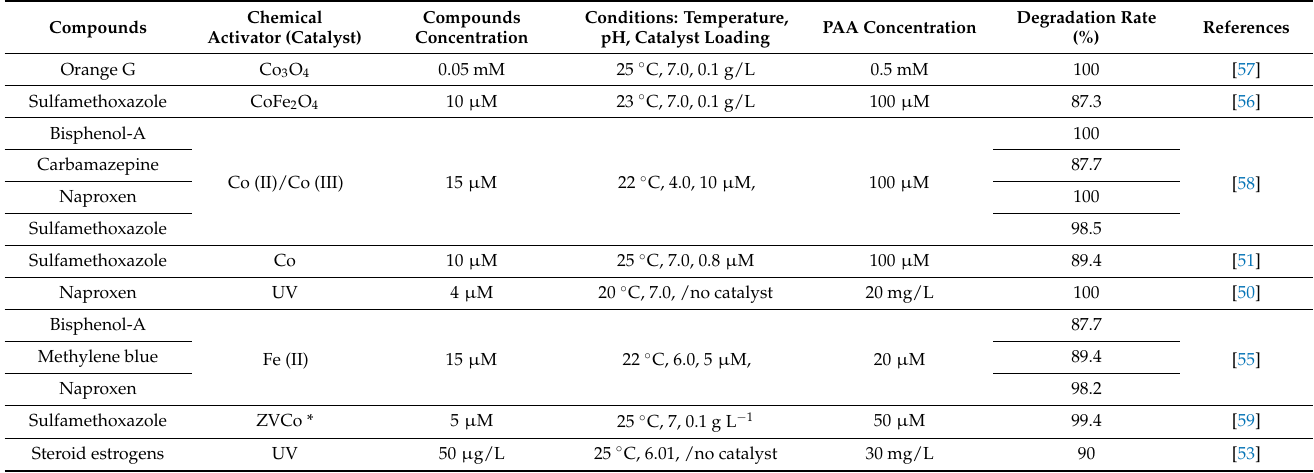
Figure 2. Free radicals generated by PAA in the presence of the metal ions activators (Cu 2+ , Co 2+ , Fe 2+ , and Mn 2+ ). Table 2. Degradation of organic pollutants by chemical activation